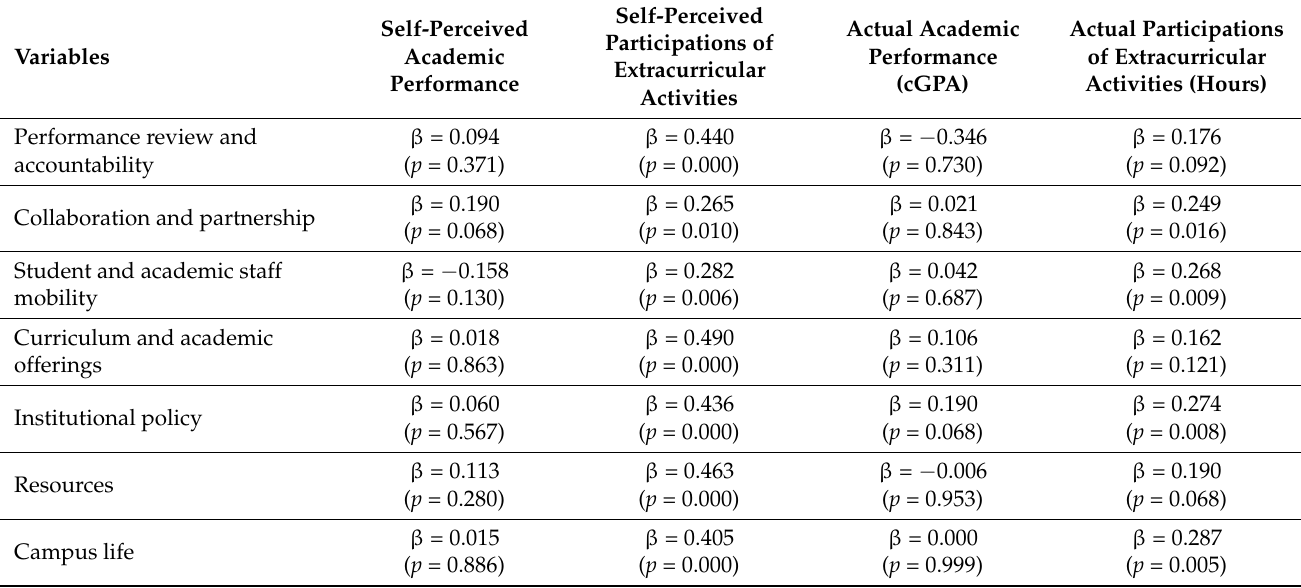
Table 4. Impact of performance indicators on dental student